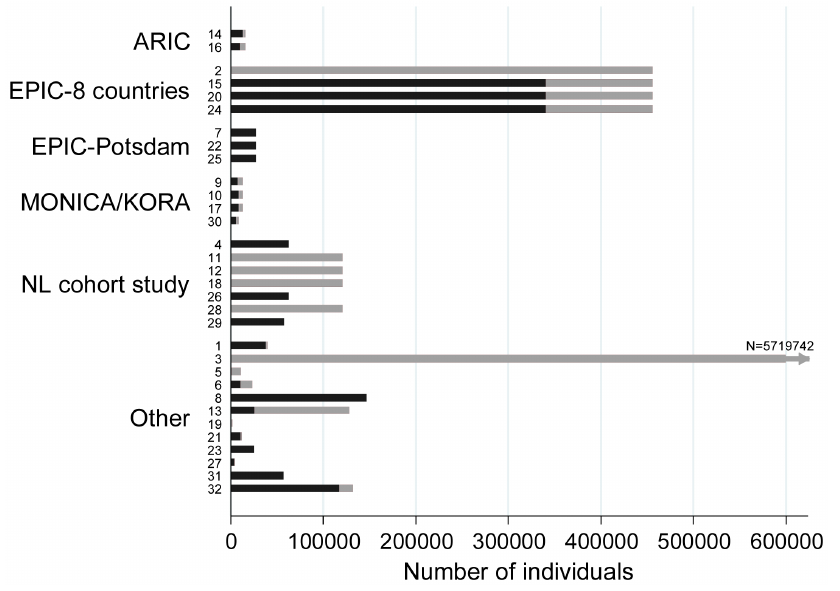
Figure 2. Number of individuals in original cohort on which case-cohort study is based, before and after exclusions. Total length of bar represents number before exclusions, length of black bar represent number after exclusions. Where the bar is all black, the size of the original cohort after exclusions was not reported. Where the bar is all grey, there were no exclusions from the original cohort. Bars are labelled according to the number of the paper in the reference list in Appendix S2.